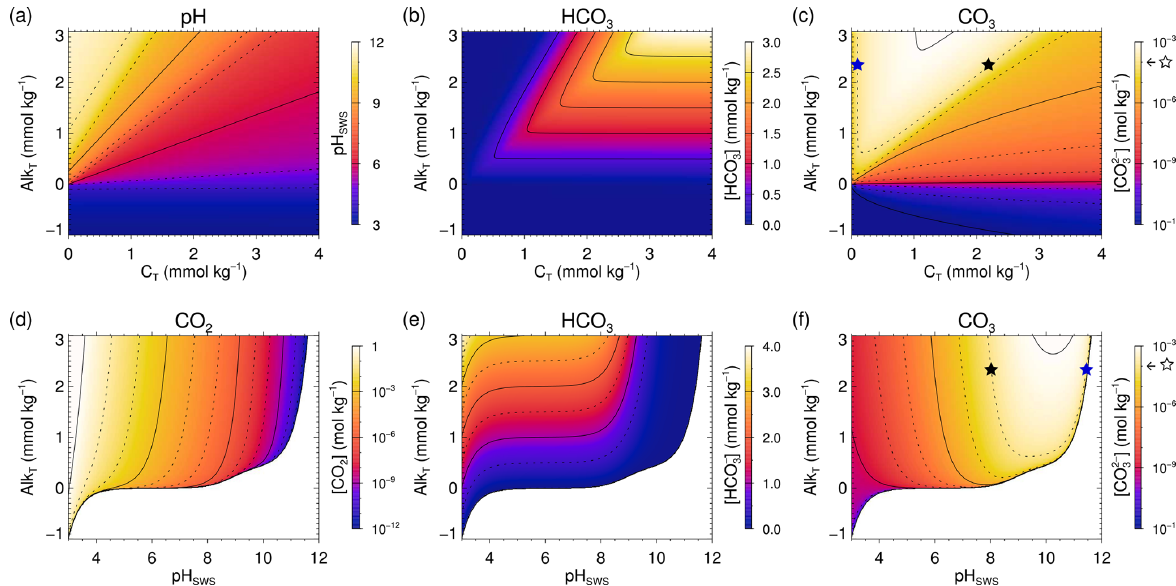
and (f) CO 2 − concentration isolines 3 3 ] = 0 . 1mmolkg − 1 3